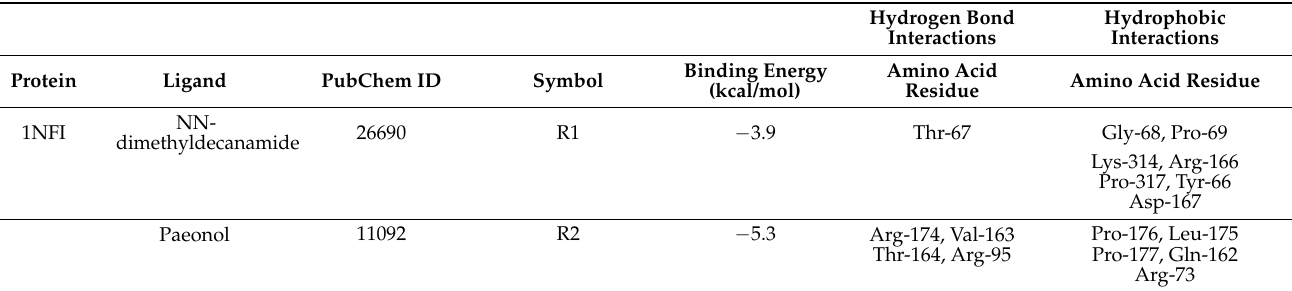
Table 3. Binding energy of potential active compounds on RELA (PDB